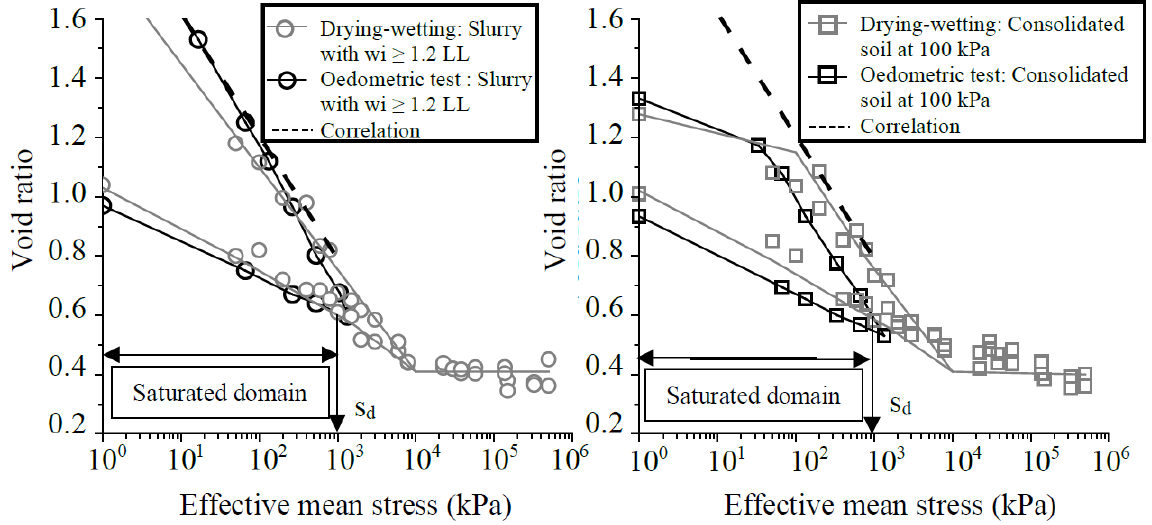
Figure 7: Comparison between drying-wetting and oedometric